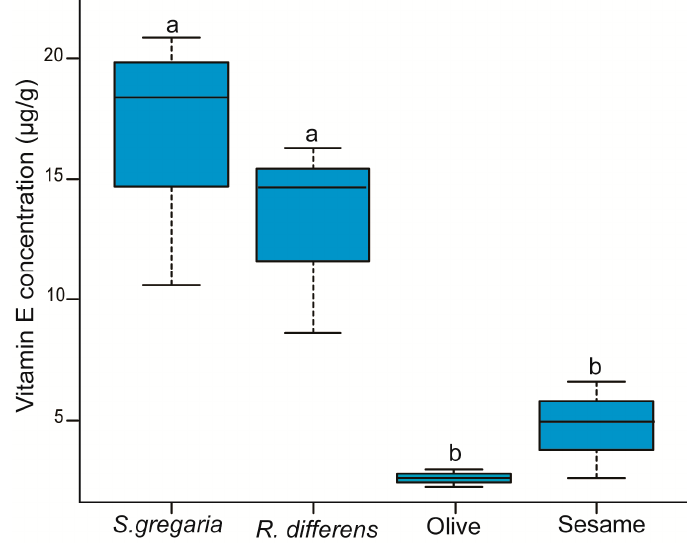
Figure 2. Boxplot showing vitamin E concentration in the different insect and plant oils. On each boxplot, the minimum and maximum values of all the data are represented by the ends of boxplot whiskers. Box plots with different letters are significantly different from each other (ANOVA followed by Student–Neuman–Keul’s (SNK’s) post-hoc test; p < 0.05 , n = 3).